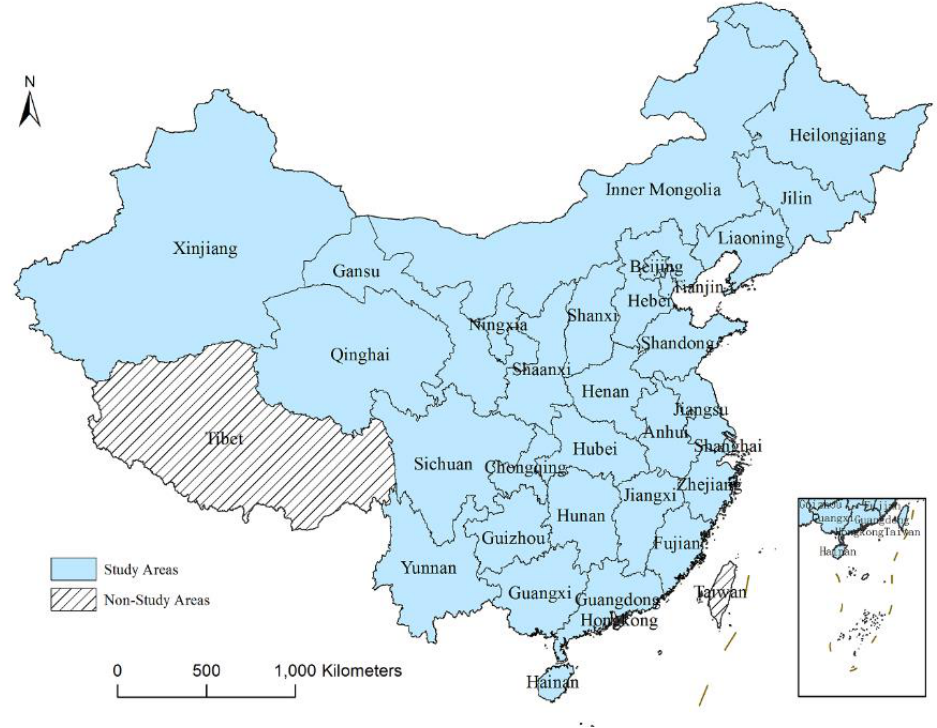
Figure 1. Study areas of China.